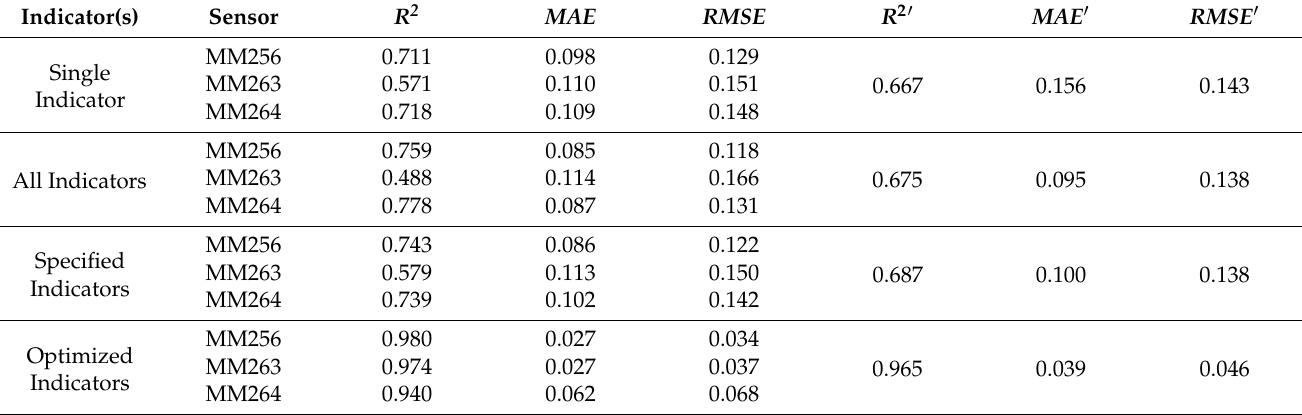
Table 2. The evaluation of gas concentration prediction results by different indicators models.